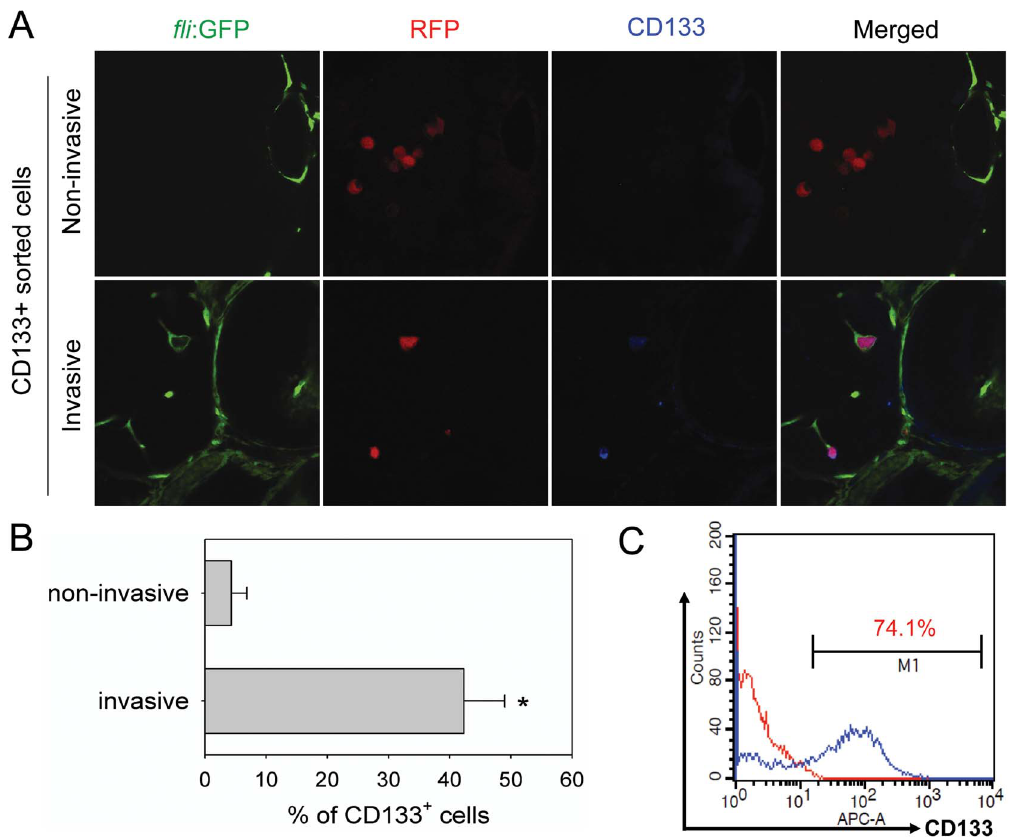
Figure 4. CD133 expression on GSCs is reduced after spread in zebrafish embryos. A. CD133 expression examined on non-invasive or invasive cells in the embryos injected with CD133 + U87 GSCs. All CD133 + U87 GSCs within injected embryos were stained with a monoclonal anti- CD133 antibody (1:300) and examined by confocal microscopy. Green: EGFP-labeled endothelial cells; red: RFP-labeled U87 sphere cells; blue: CD133 + U87 GSCs. B. The percentage of CD133 + cells in non-invasive cells or invasive cells at 2 dpi (n=300 each group). C. Detection of CD133 + cell percentage in sorted CD133 + U87 cells in preparation for microinjection by flow cytometry ( p , 0.001).